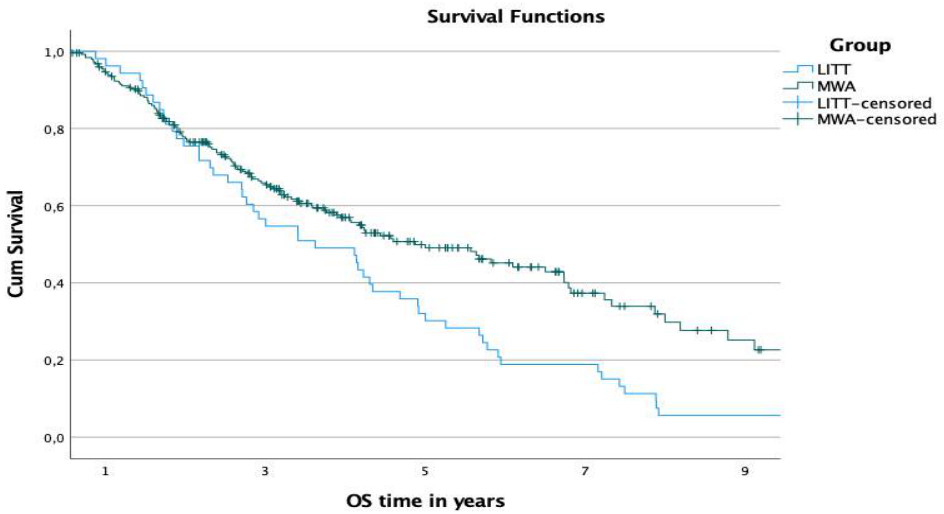
Figure 3. Comparison of OS rates of both groups starting at the date of diagnosis. The 1-, 3-, and 5-year OS rates from the ablation date were 86.6%, 53.4%, and 40.4% in